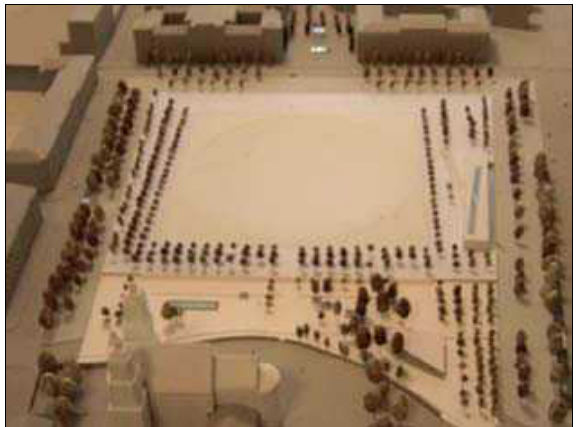
Fig. 12. Field of Memory (Memorial to the murdered Jews of europe). Peter eisenman with participation of sculptor